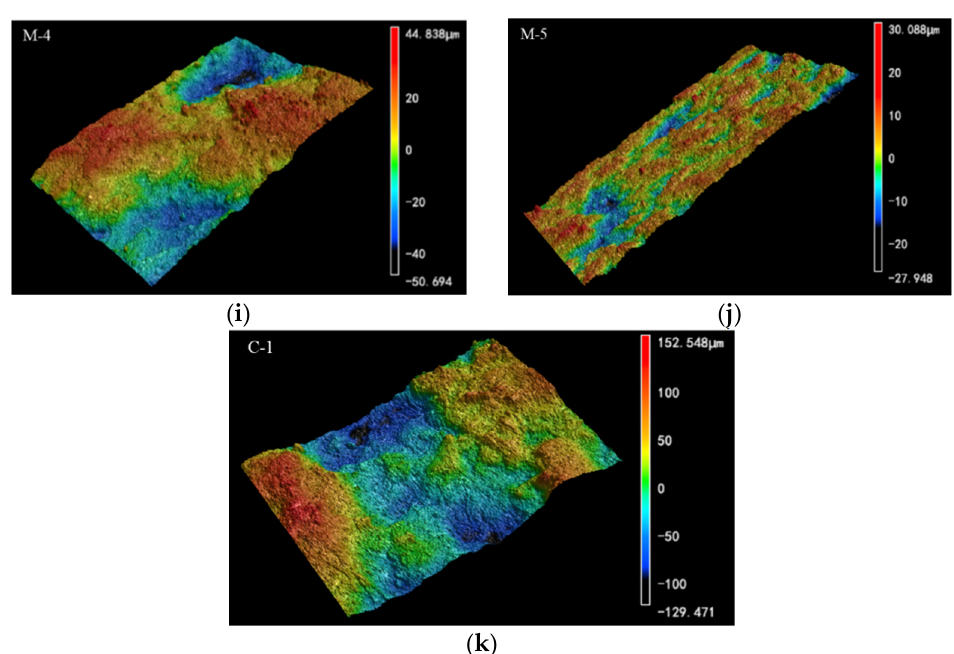
Figure 5. The three-dimensional view of the roughness of partial fracture surface. ( a ) Sample L-1; ( b ) sample L-2; ( c – e ) samples Y-3–Y-5; ( f – j ) samples M-1–M-5; ( k ) sample C-1.